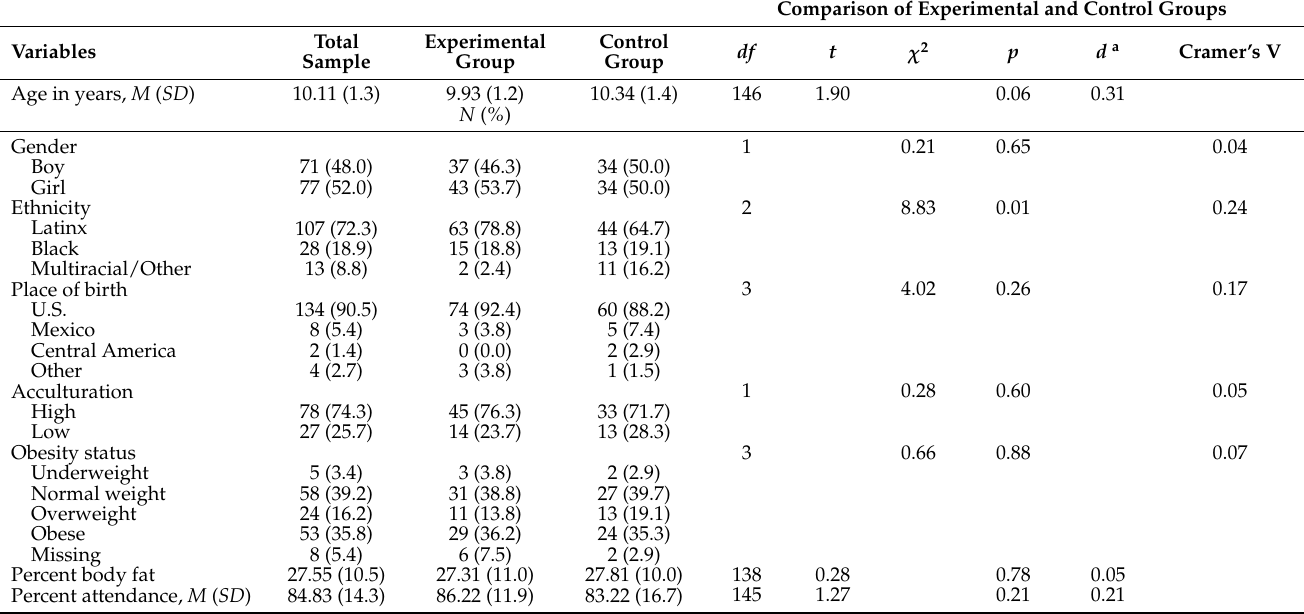
Table 1. Baseline sample descriptive characteristics ( N = 148, n EG = 80, n CG =